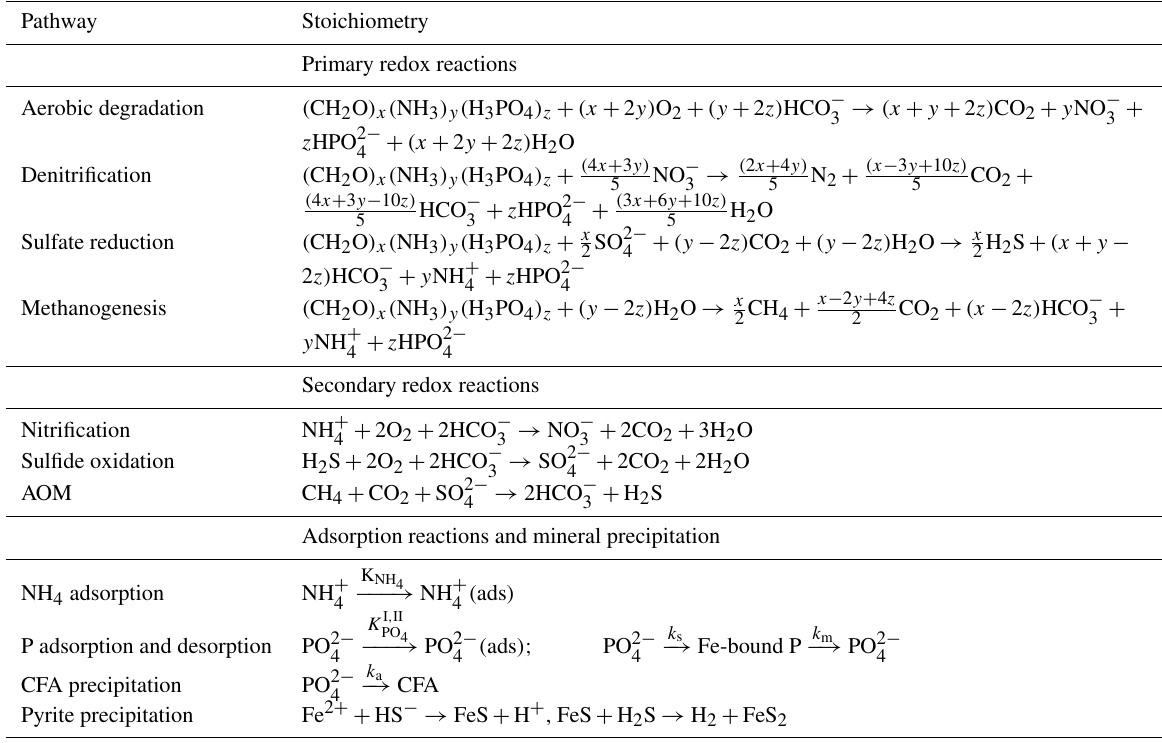
Table A1. Primary pathways of organic matter degradation, secondary redox reactions and stoichiometries implemented in the reaction